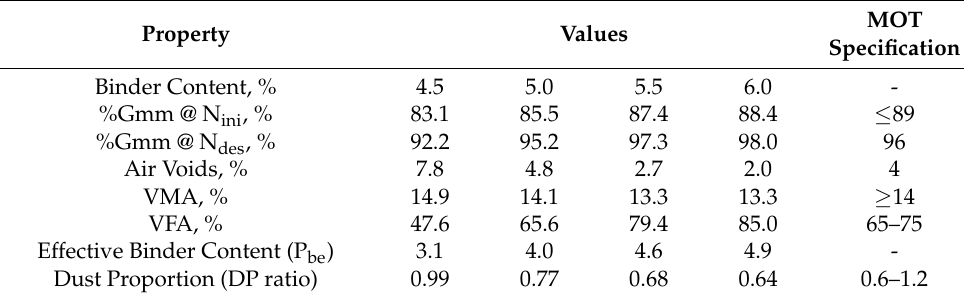
Table 6. Volumetric properties for different asphalt binder content.